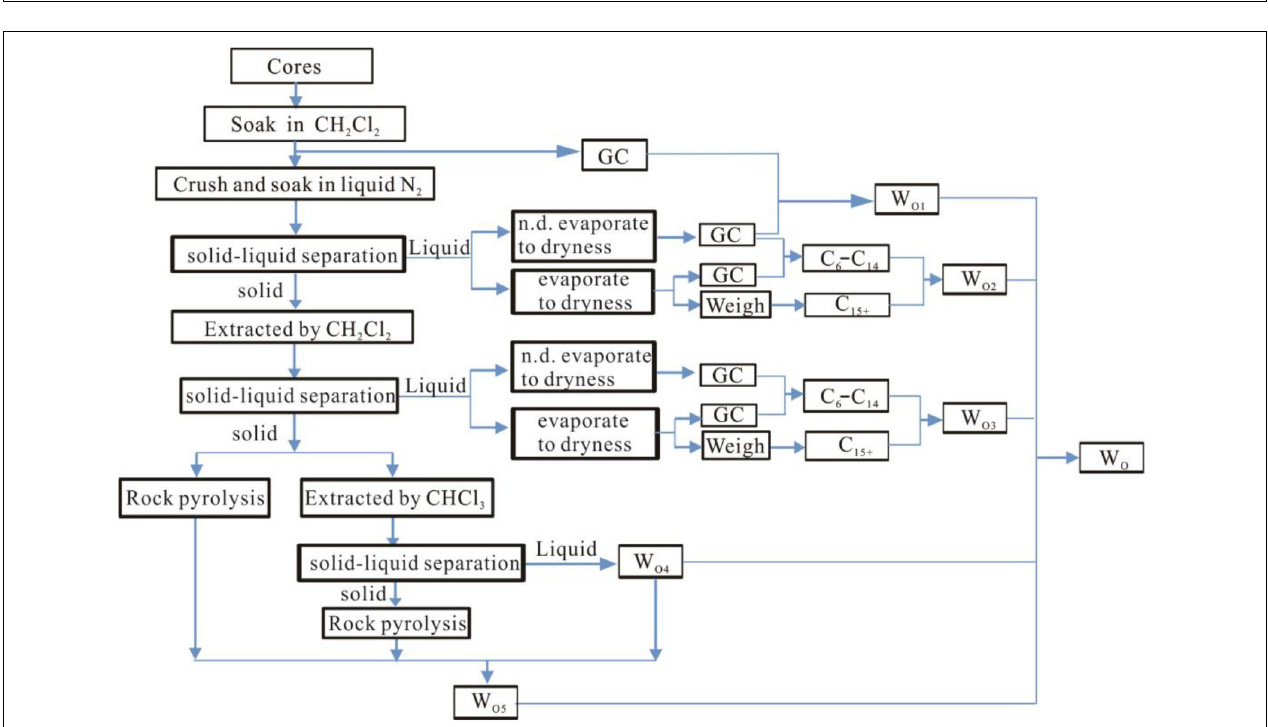
FIGURE 6 | Measuring procedures of the retained oil content in organic-rich shale.